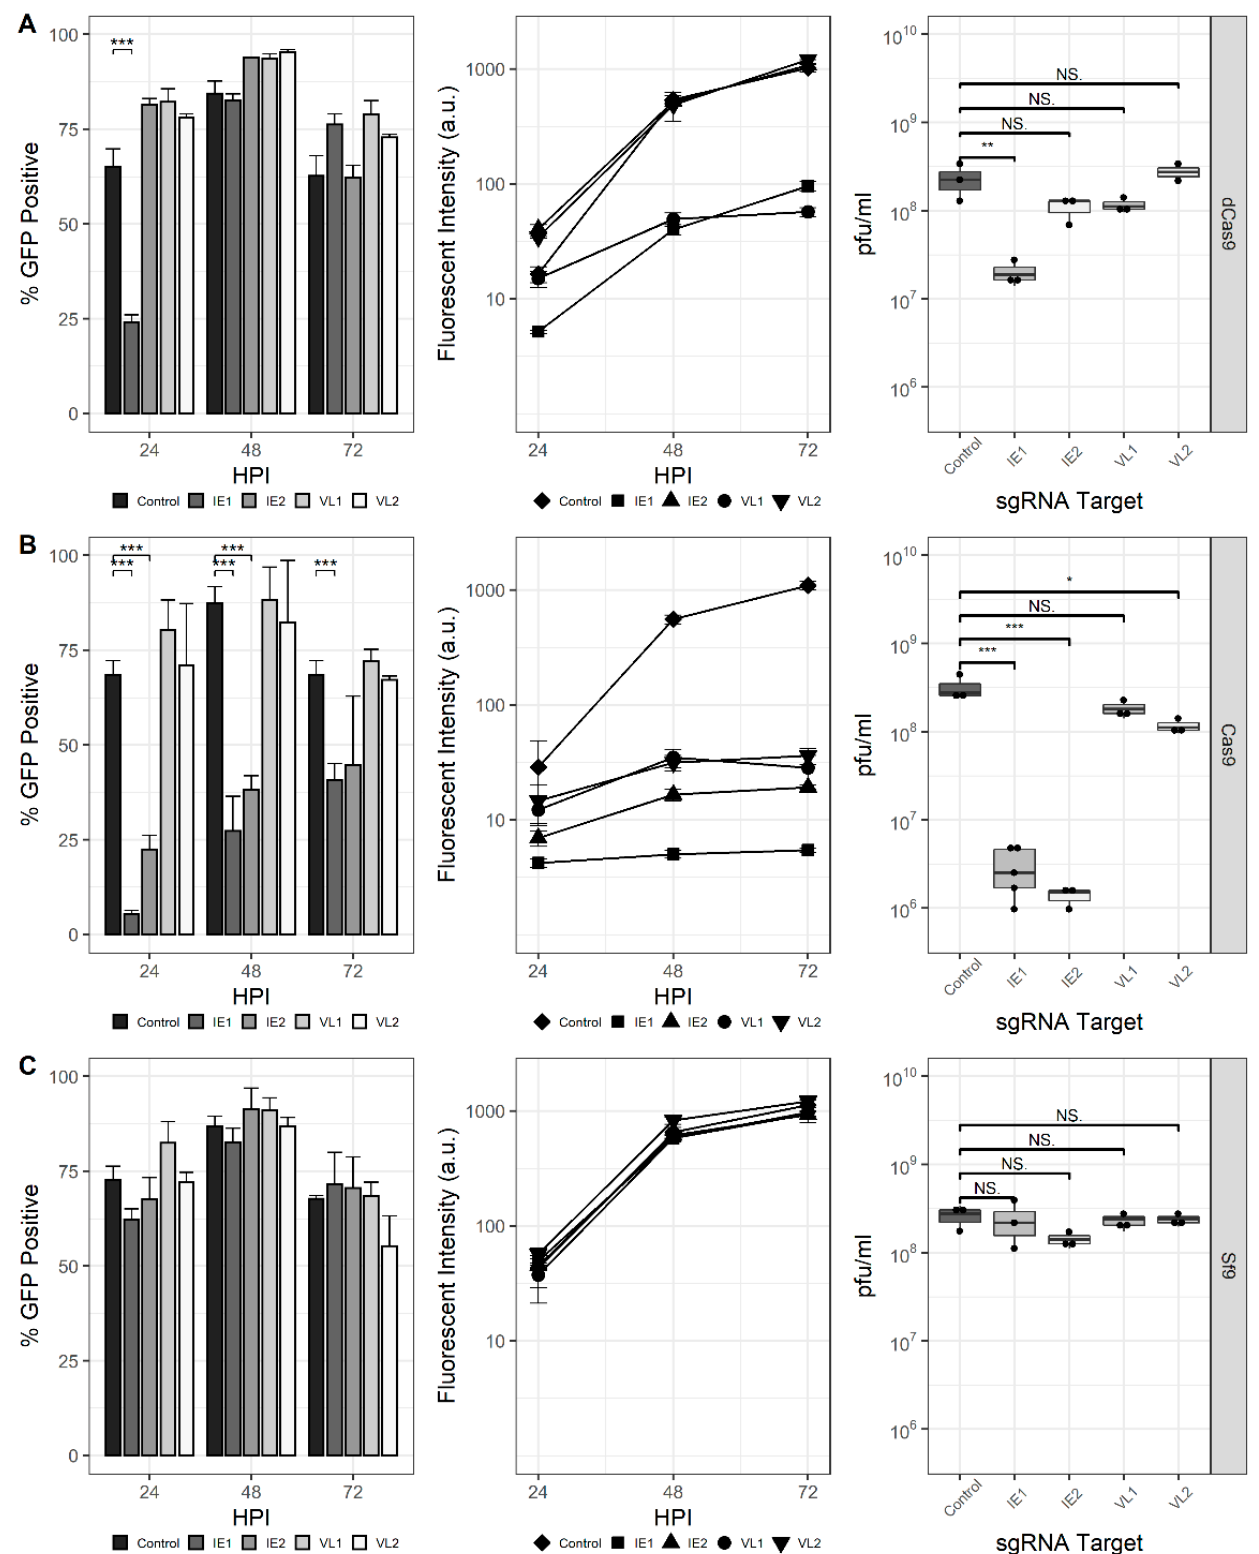
Figure 3. CRISPR-mediated targeting of the AcMNPV ie-1 and vlf-1 genes. Percent GFP-positive, fluorescence intensity, and IVT for rBEVs in ( A ) Sf-dCas9, ( B ) Sf9-Cas9, and ( C ) parental Sf9 cells. ***: p < 0.001; **: p < 0.01; *: p < 0.05; NS: non-significant.